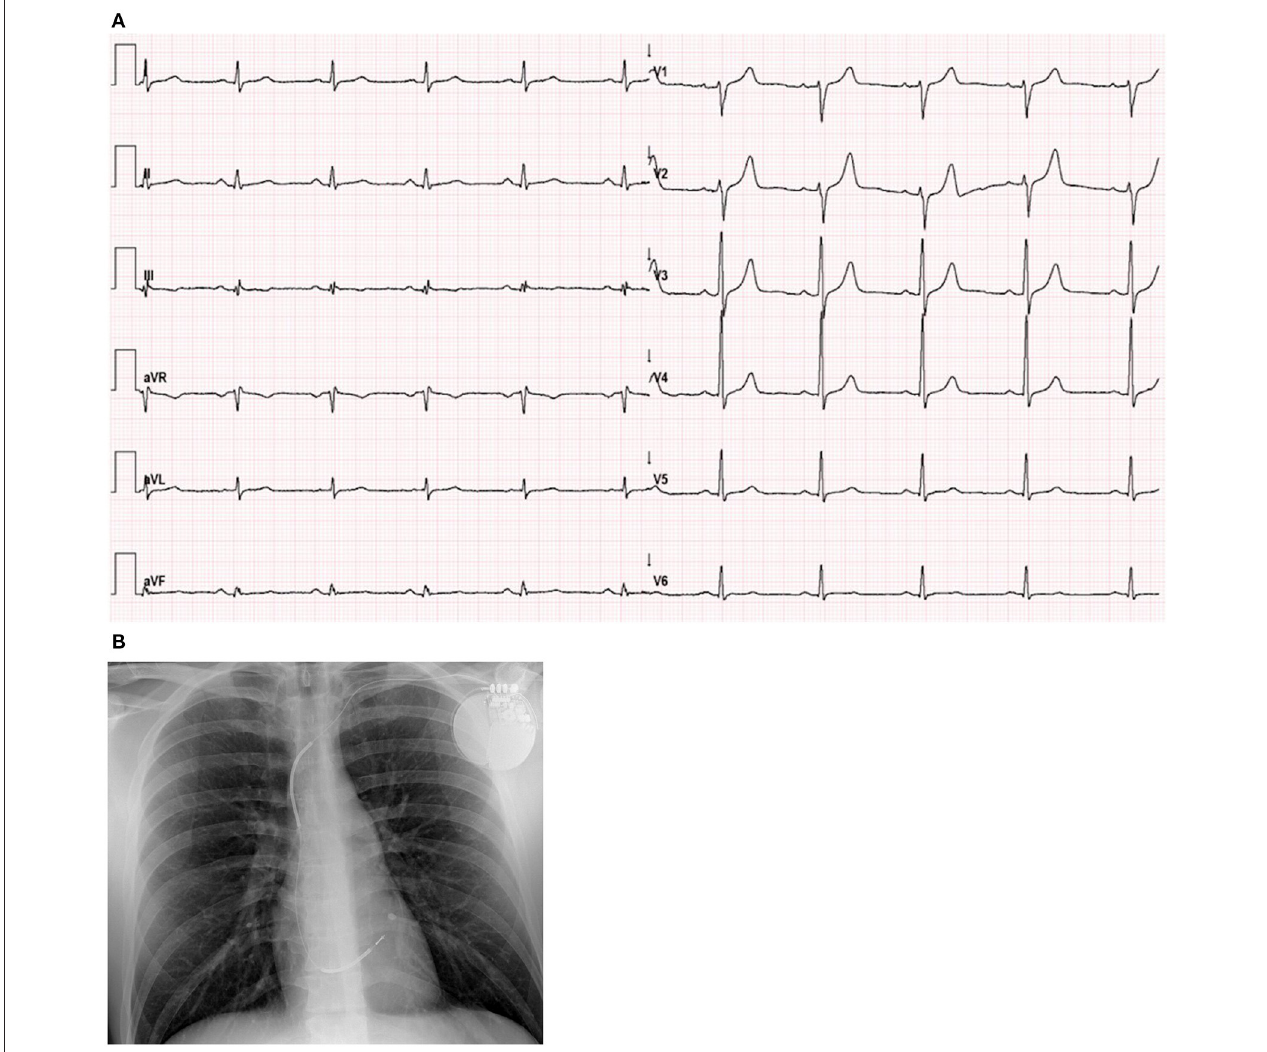
FIGURE 1 | Electrocardiogram and Chest X-ray. (A) ECG showed sinus rhythm, 60 bpm, normal axis, fragmented QRS in the inferior leads (III, aVF) and flat T waves in III, aVF and V6. When compared to previous ECGs, no new abnormalities were observed. (B) Chest X-ray with a single lead ICD, normal heart size and no signs of pulmonary